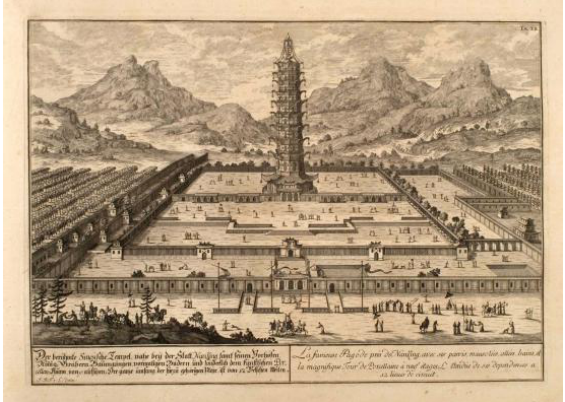
Figure 2. The Porcelain Pagoda as illustrated in Fischer von